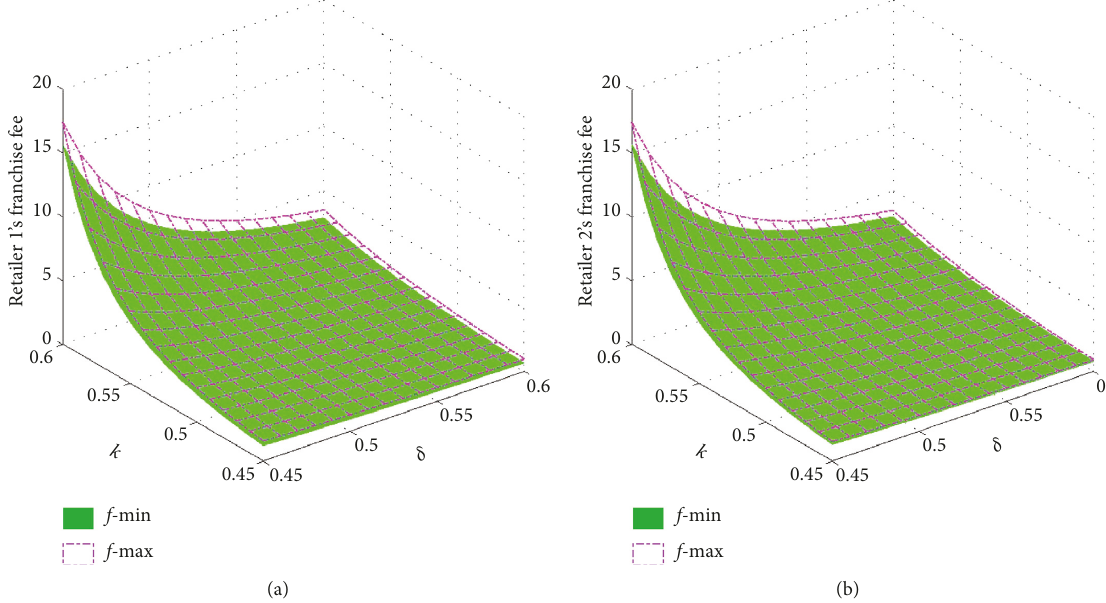
Figure 13: Feasible lower and upper bounds of franchise fees vs. k and δ in the R